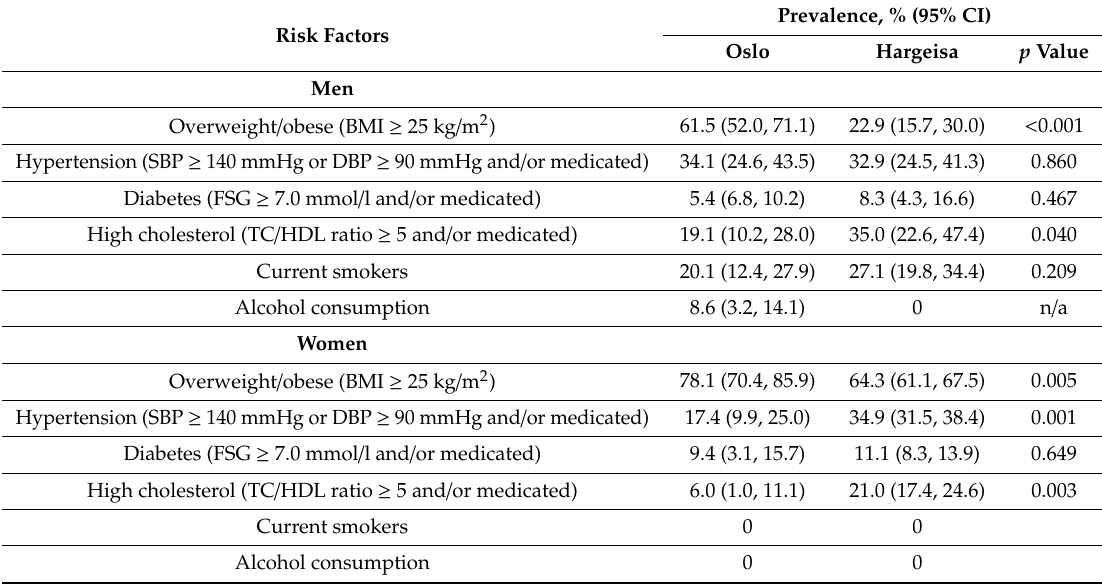
Table 3. Prevalence (%) of risk factors among men and women from Oslo and Hargeisa, age adjusted a . Prevalence, % (95% CI) Risk Factors Oslo Hargeisa p Value Men Overweight / obese (BMI ≥ 25 kg / m 2 ) 61.5 (52.0, 71.1) 22.9 (15.7, 30.0) < 0.001 Hypertension (SBP ≥ 140 mmHg or DBP ≥ 90 mmHg and / or medicated) Diabetes (FSG ≥ 7.0 mmol / l and / or